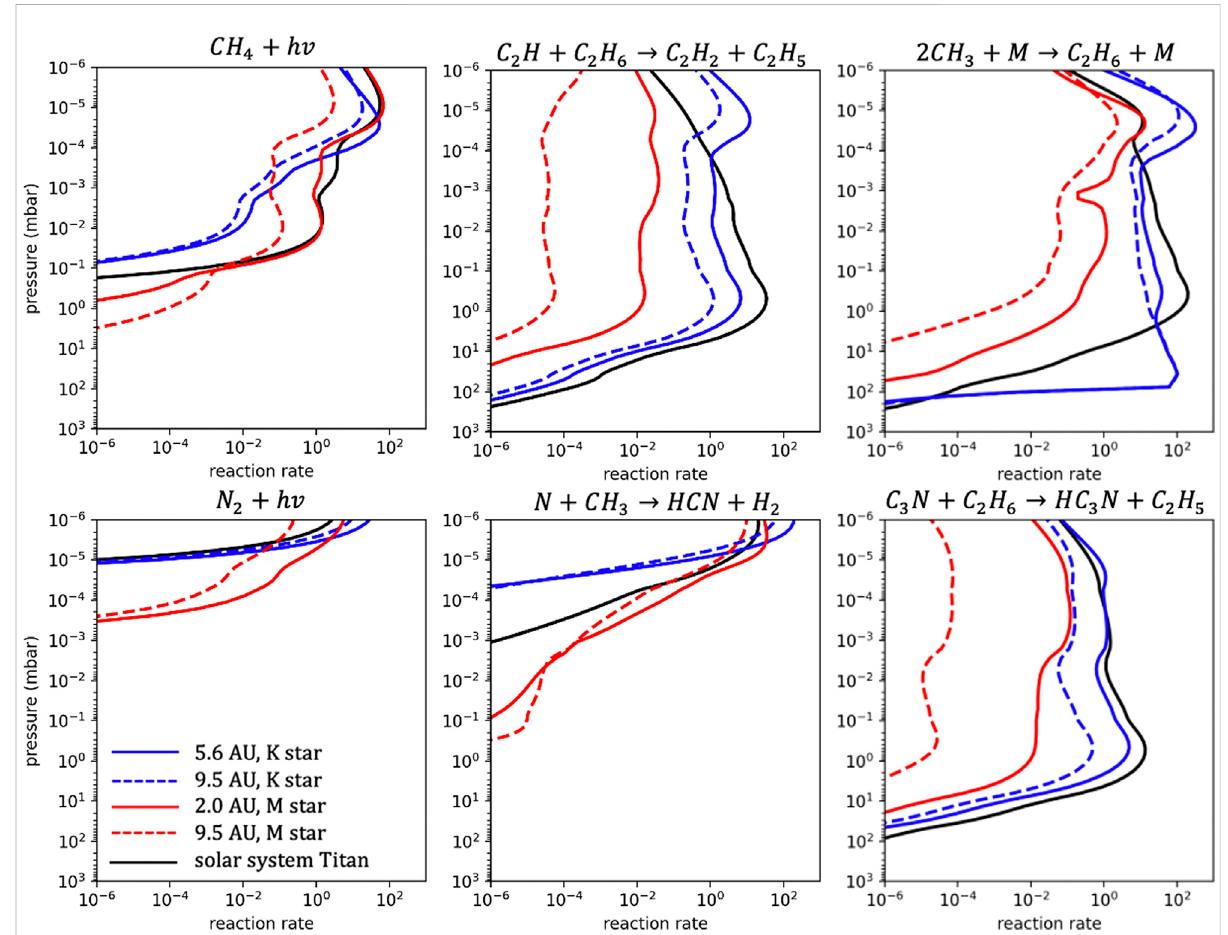
Reaction rates (cm − 3 · s − 1 ) of dominant production and destruction reactions for C 2 H 6 . Black lines represent solar system Titan, solid red lines representTitanaroundanM-Dwarfat2 AU,dashedredlinesrepresentTitanaroundandM-Dwarfat9.5 AU,solidbluelinesrepresentTitanarounda K star at 5.6 AU, and dashed blue lines represent Titan around a K star at 9.5